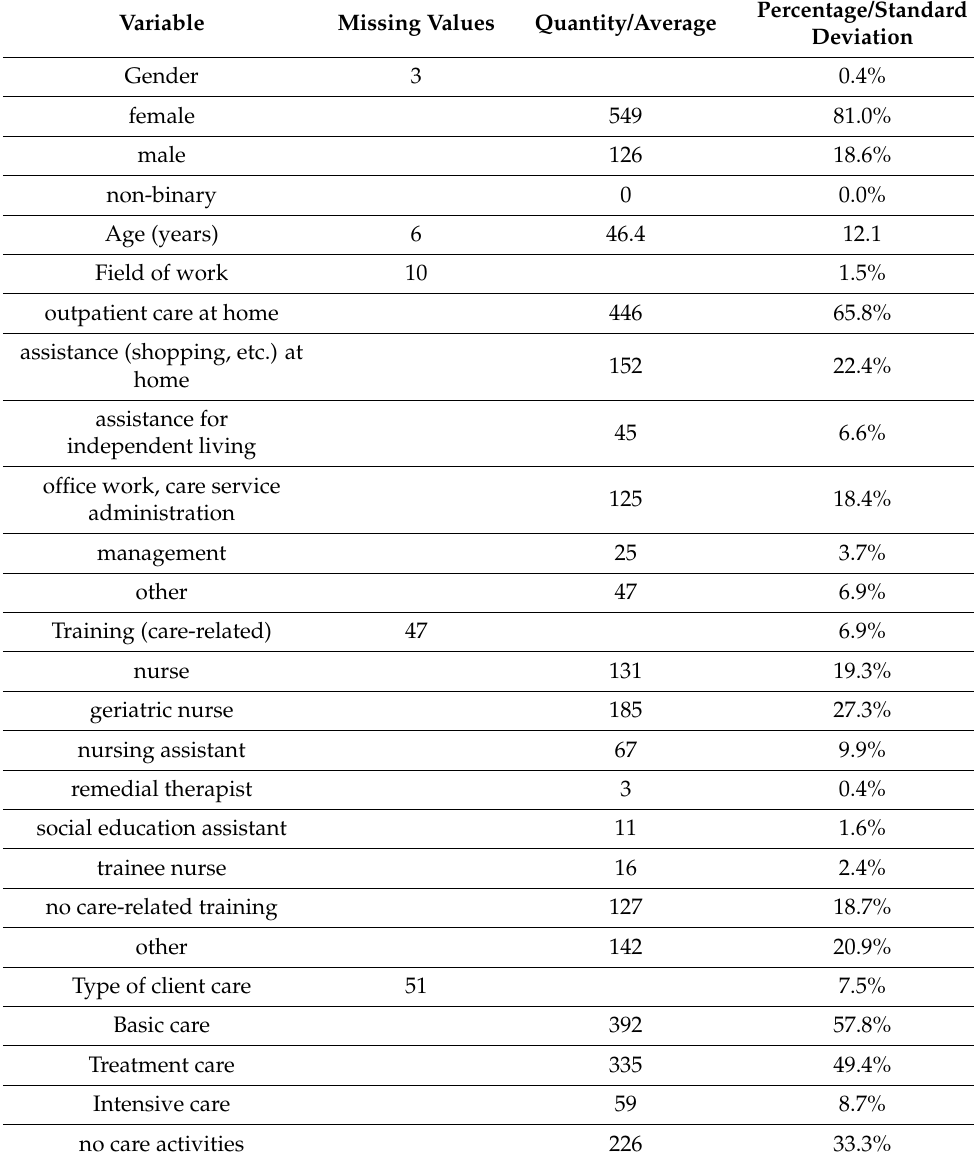
Table 1. Description of the study population (n =